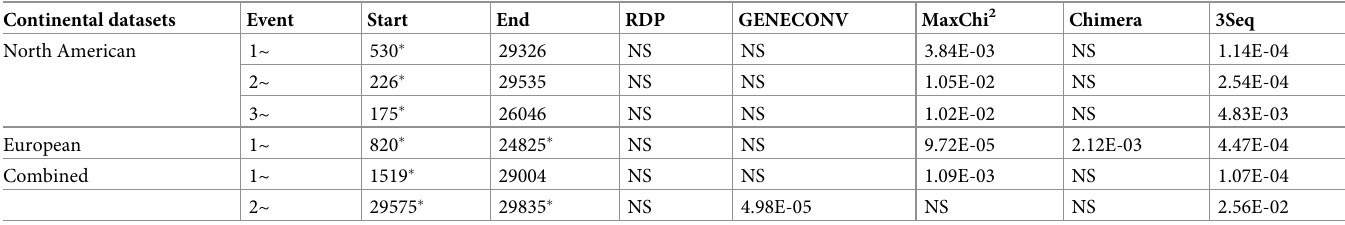
Table 2. Plausible recombination events validated by RDP4 suite.